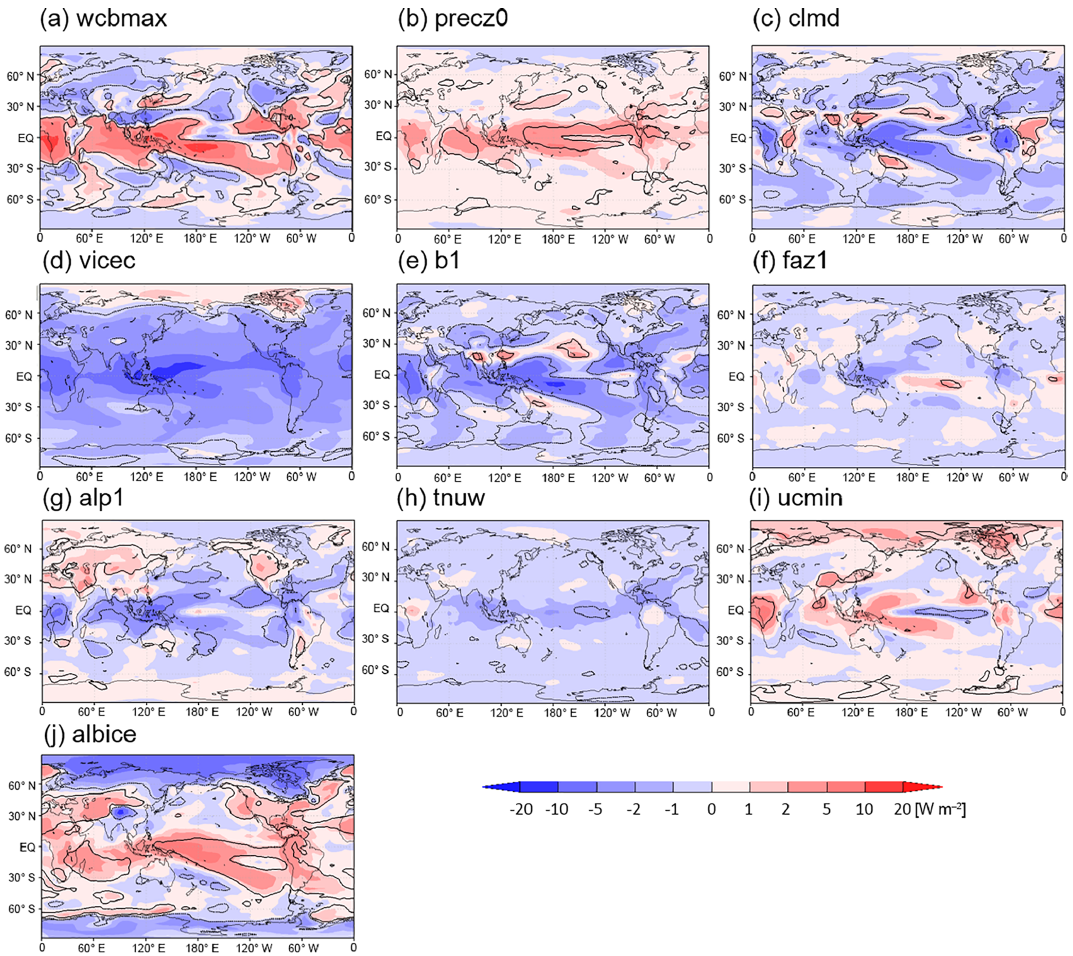
Figure 8. Regression coefficient of the annual mean TOA longwave CRE on the tuning parameters calculated using the 56 samples of the MIROC5 PPE. The definition of the tuning parameters is shown in Table 1. The tuning parameters are normalized to the range of [0,1]. The black curves indicate the threshold of the statistical significance with the 5%